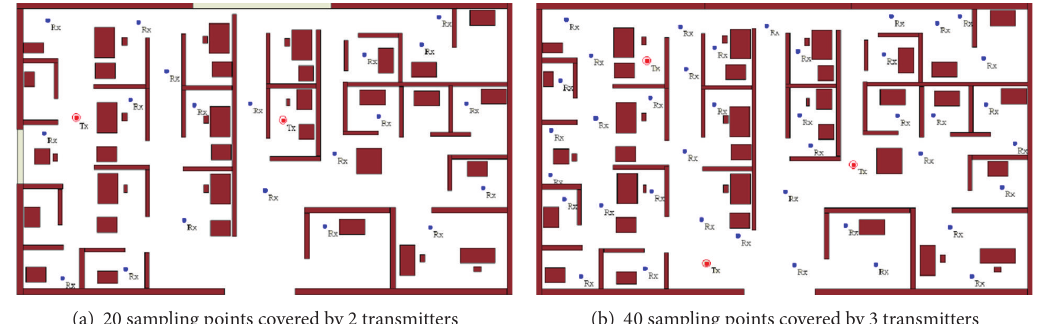
Figure 3: The floor plan of the indoor propagation area and the locations of the sampling points where the optimized positions of the transmitters are surrounded by the solid circles in hollow circles.